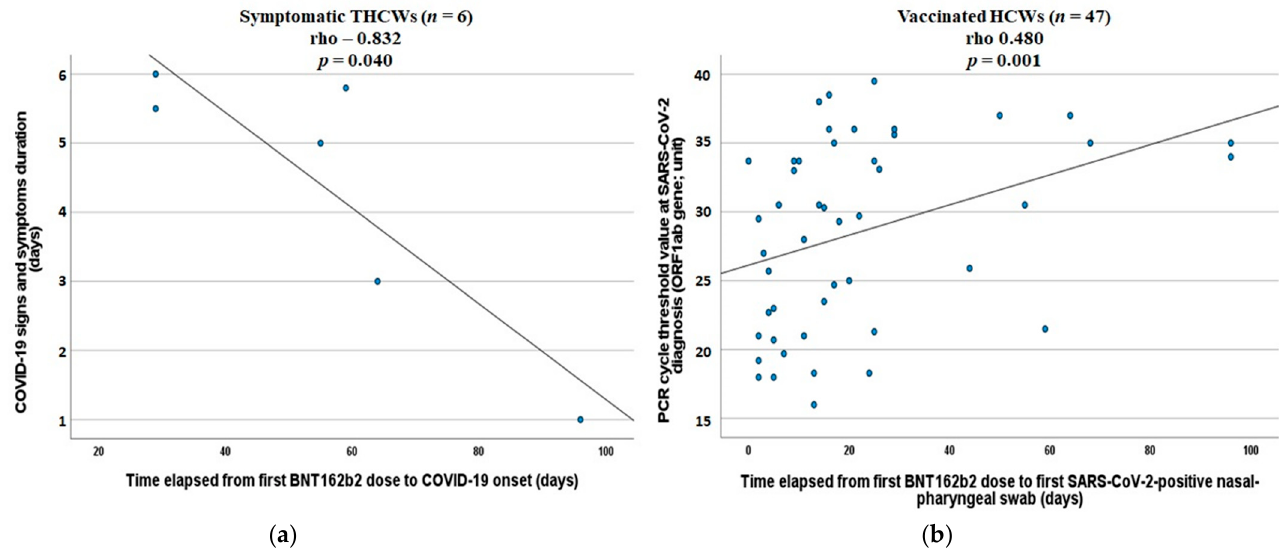
Figure 2. Comparison of SARS-CoV-2 PCR cycle threshold values across the study population. Comparison of PCR cycle diagnosis between corresponding unvaccinated sex- and age-matched controls and post-first dose vaccinated health care workers ( a ), partially vaccinated health care workers ( b ), and totally vaccinated health care workers ( c ). Legend: HCWs, health care workers, PCR, polymerase chain reaction. * Significant differences ( p < 0.05) were highlighted.